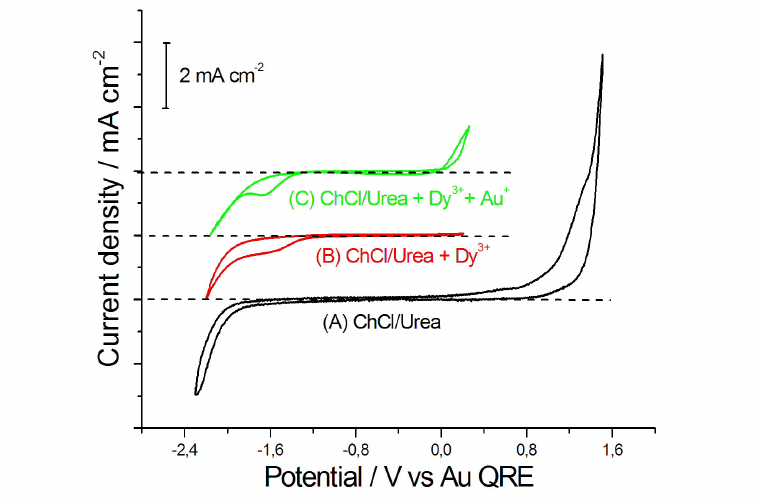
Figure 1. Cyclic voltammetries (scan rate: 100 mV·s − 1 ) for a glassy carbon electrode in: 250 mM; ( C ) 2:1 urea/ChCl with DyCl ( A ) 2:1 urea/ChCl; ( B ) 2:1 urea/ChCl with DyCl 3 250 mM and KAu(CN) 10 2